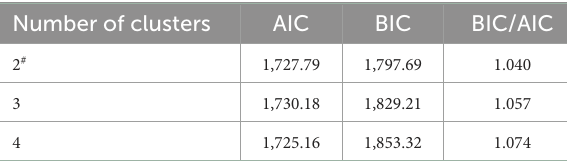
TABLE 1 Akaike Information Criterion (AIC) and Bayesian Information Criterion (BIC) of the latent class